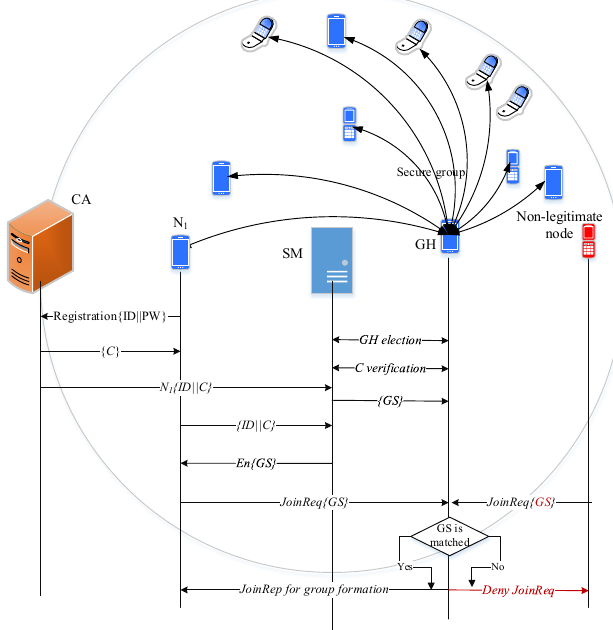
Figure 3 . SCGF algorithm based group